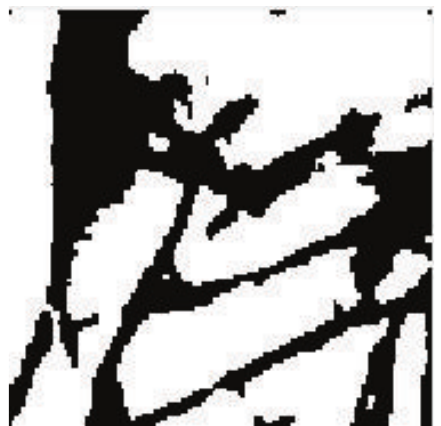
Figure 8: Sample image found during matching.